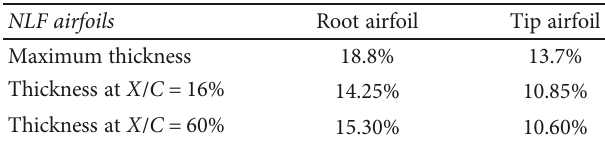
Table 3: NLF-optimized airfoils – relative thicknesses at given